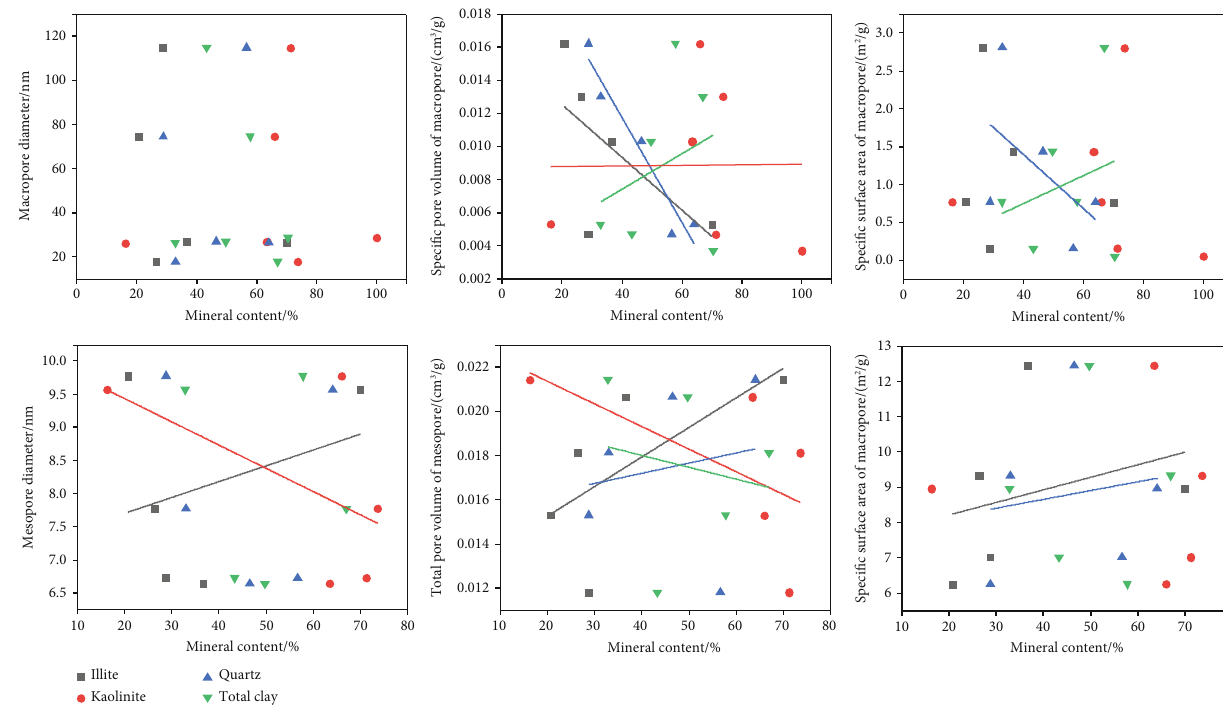
Figure 11: Relationship between main mineral composition and pore structure parameters of shale sample.